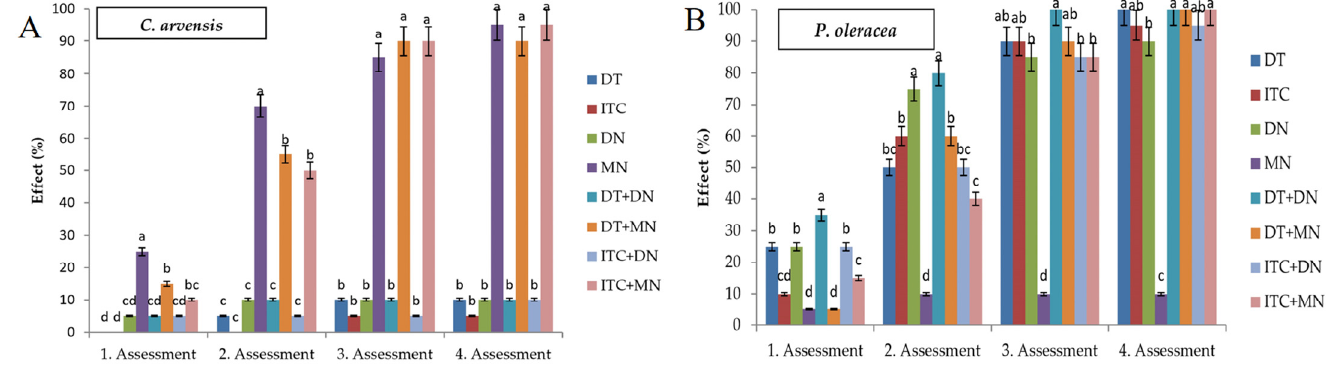
Figure 5. Effect of herbicides on ( A ) C. arvensis and ( B ) P. oleracea at different intervals. The differences between the means with the same letter are not significant at the 0.05 level.